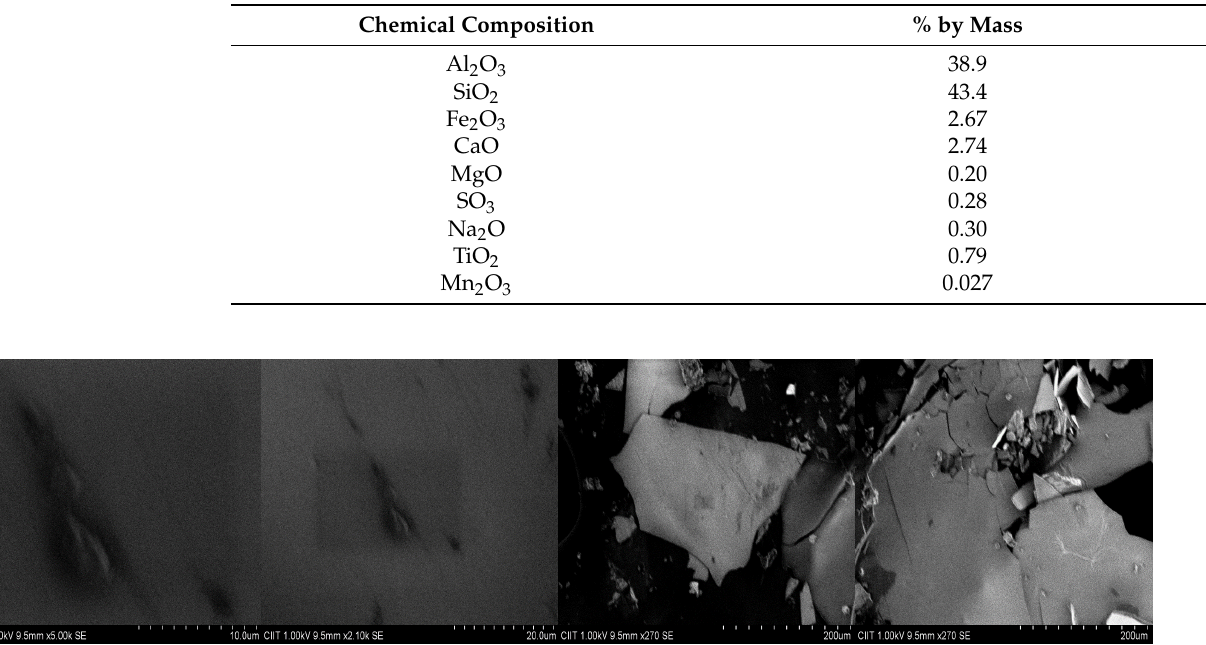
Table 6. Chemical composition of metakaolin.